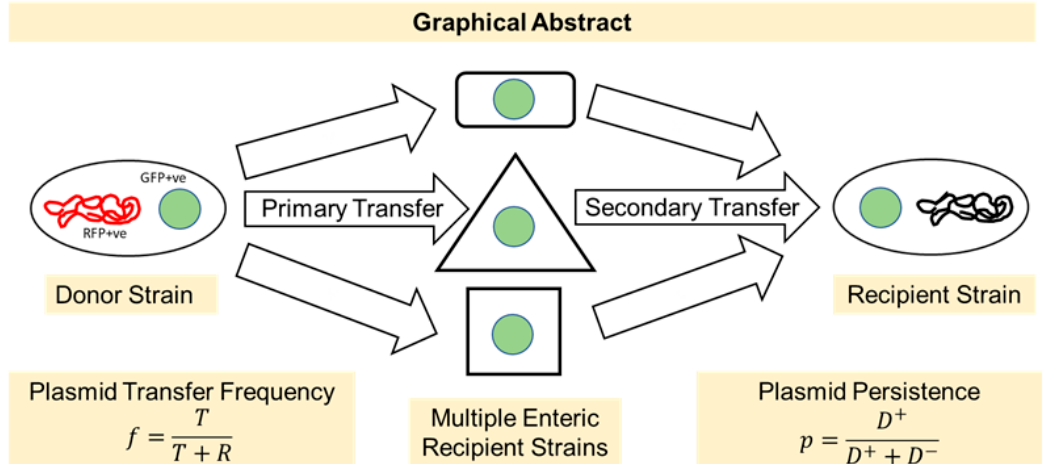
Figure 1. Graphical abstract showing the experimental design used in this study. We studied the transfer frequencies of a broad-host-range RP4 plasmid among multiple clinically relevant bacteria. In the primary transfer, the RP4 plasmid was transferred from E. coli LM715-1 to different enteric commensal and pathogenic bacteria, and in the secondary transfer, we observed the transfer of RP4 plasmid to E. coli LM715-1 from all plasmid recipients of primary transfer. Plasmid persistence was also studied in E. coli LM715-1 using a serial passage approach.